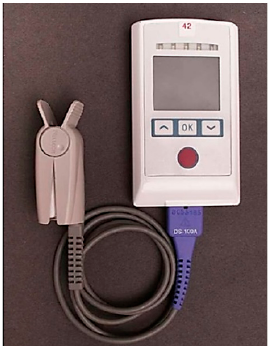
Figure 9. A monitor that can both display and transmit vital signs [17].